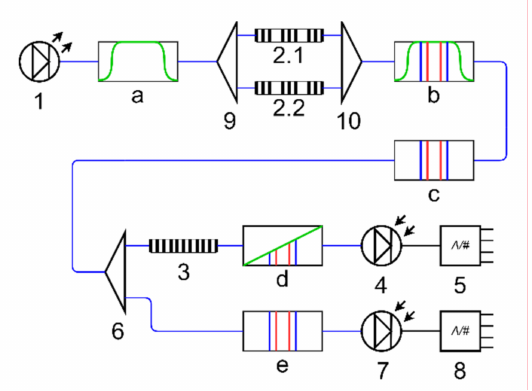
Figure 3. Structure of the interrogation system for two addressed fiber Bragg structure (AFBS)-based sensors: (1) wideband light source, (2.1, 2.2) AFBS sensors, (3) optical filter with a linear inclined frequency response, (4) photodetector of the measuring channel, (5) analog-to-digital converter (ADC) of measuring channel, (6,9) fiber-optic splitters, (7) photodetector of the reference channel, (8) ADC of the reference channel, (10) fiber-optic coupler, (a) spectrum of the wideband light source, (b,c) are the spectra of light propagated through the AFBS sensors, (d) spectra of AFBS sensors at the output of the optical filter, (e) spectra of AFBSs in the reference channel; blue connection lines denote optical fibers, black connection lines represent electrical